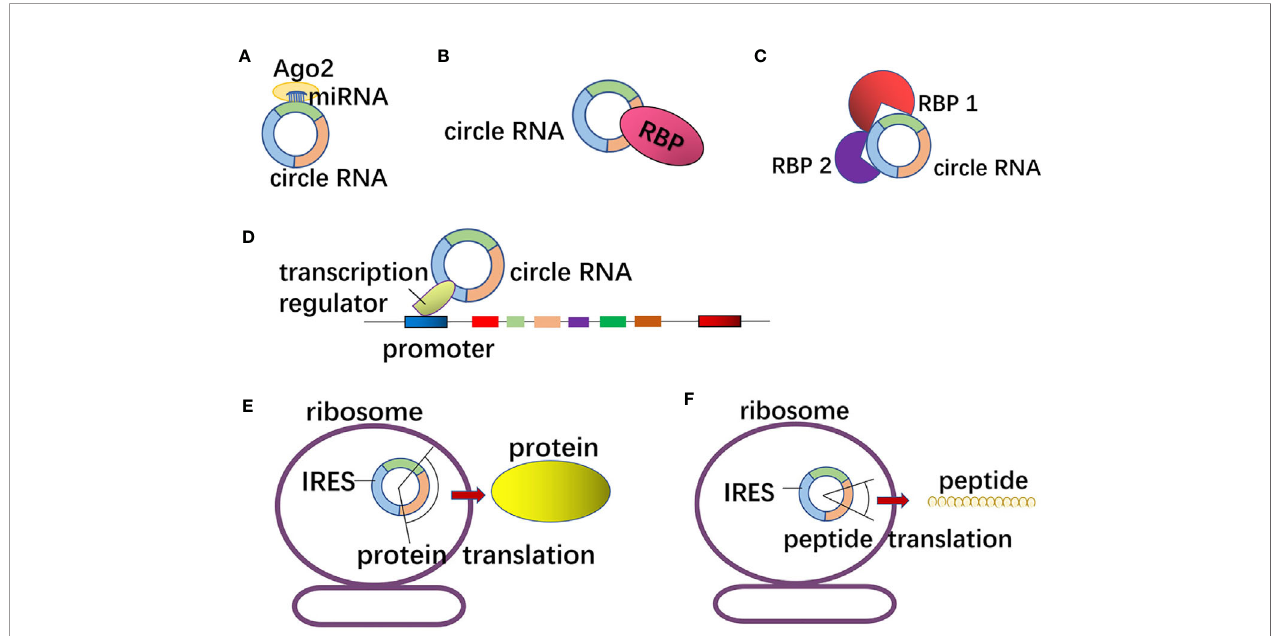
FIGURE 3 | The mechanism of circRNA in gastrointestinal tumors. (A) CircRNAs can act as miRNA sponge or decoys as well as regulate the function of downstream mRNA. (B) CircRNAs with RNA binding protein (RBP) binding motifs may sponge or decoy the RBPs and regulate their functions. (C) A few circRNAs can combine with several RBPs and function as protein scaffolds to affect the tumor progressions. (D) Some circRNAs are involved in gene transcription regulation by recruiting the transcription regulators to in fl uence promoters. (E, F) CircRNAs containing internal ribosome entry site (IRES) elements and AUG sites may act as templates as well as be